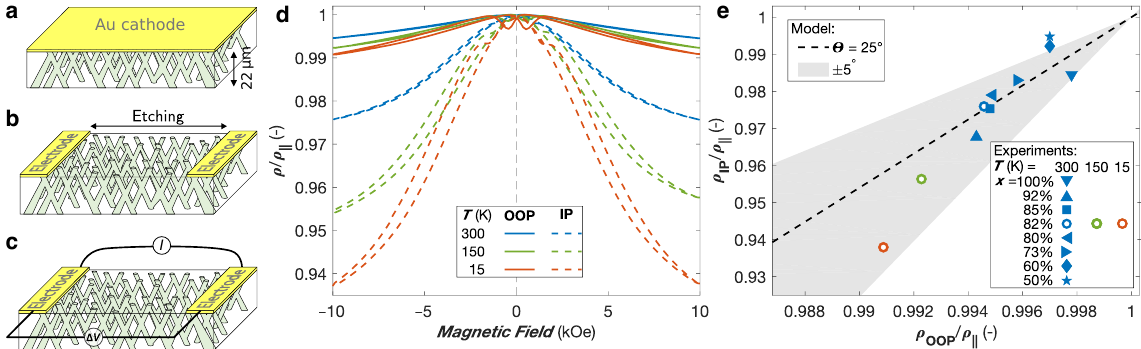
Figure 3. ( a ) Schematic of a 3D interconnected nanowire network electrodeposited from a Au cathode into a 22 µ m thick nanoporous polycarbonate film. ( b ) Two-probe electrodes design created by local etching of the cathode. ( c ) Resistance measurement configuration where a current I is injected between the two metallic electrodes while recording the voltage differential ∆ V induced. ( d ) Anisotropic magnetoresistance curves measured at different temperatures by sweeping an external magnetic field along the out of the plane (OOP; continuous line) and in the plane (IP; dashed line) directions of a permalloy (Ni 82 Fe 18 ) crossed nanowire network film, deposited in a template with mean pore diameter of 80 nm, ∼ 3% of porosity. ( e ) Comparison between the model given by Equation (6) for Θ = 25 ◦ and the experimental data for nanowire networks ( φ = 80 nm, P = 3%) made of Ni x Fe 1 − x alloys with 0.5 ≤ x ≤ 1 at room temperature, together with the results at T = 150 K and T = 15 K for x = 0.82. The gray area reflects the calculated relation for Θ in the range 20 ◦ to 30 ◦